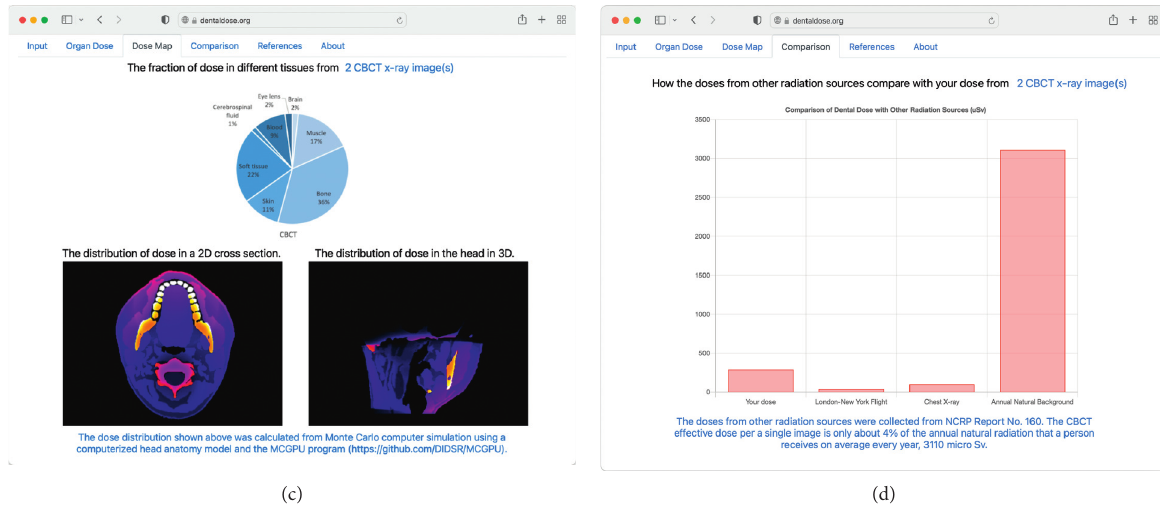
Figure 4: Web interfaces for (a) user input, (b) organ (brain, salivary gland, bone marrow, thyroid) and effective doses, (c) the fraction of dose in different tissues and 2D and 3D dose distributions, and (d) dose comparison with other radiation